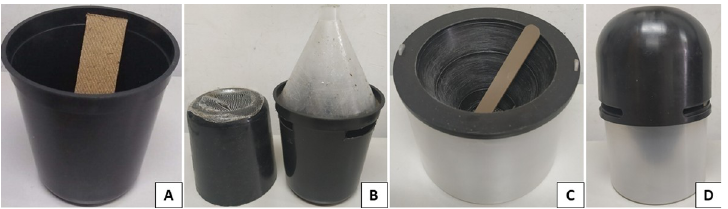
Fig 2. Traps for capture of Aedes eggs and adults under field conditions: A) UELtrap-E; B) UELtrap-EA; C) CRtrap-E; D)